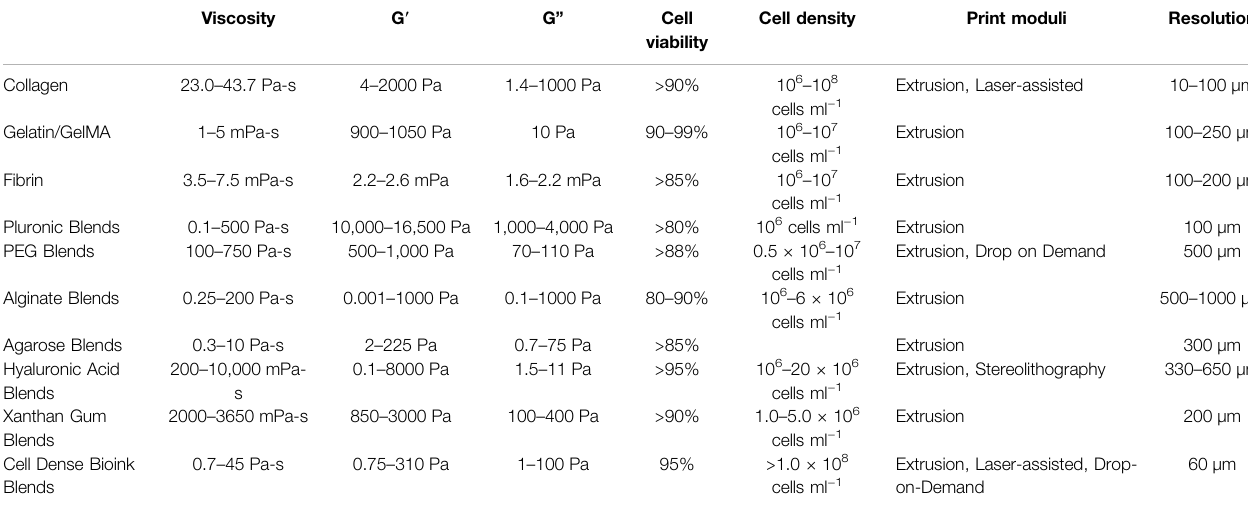
TABLE 1 | Commonly used bioinks, their respective properties, and recommended print